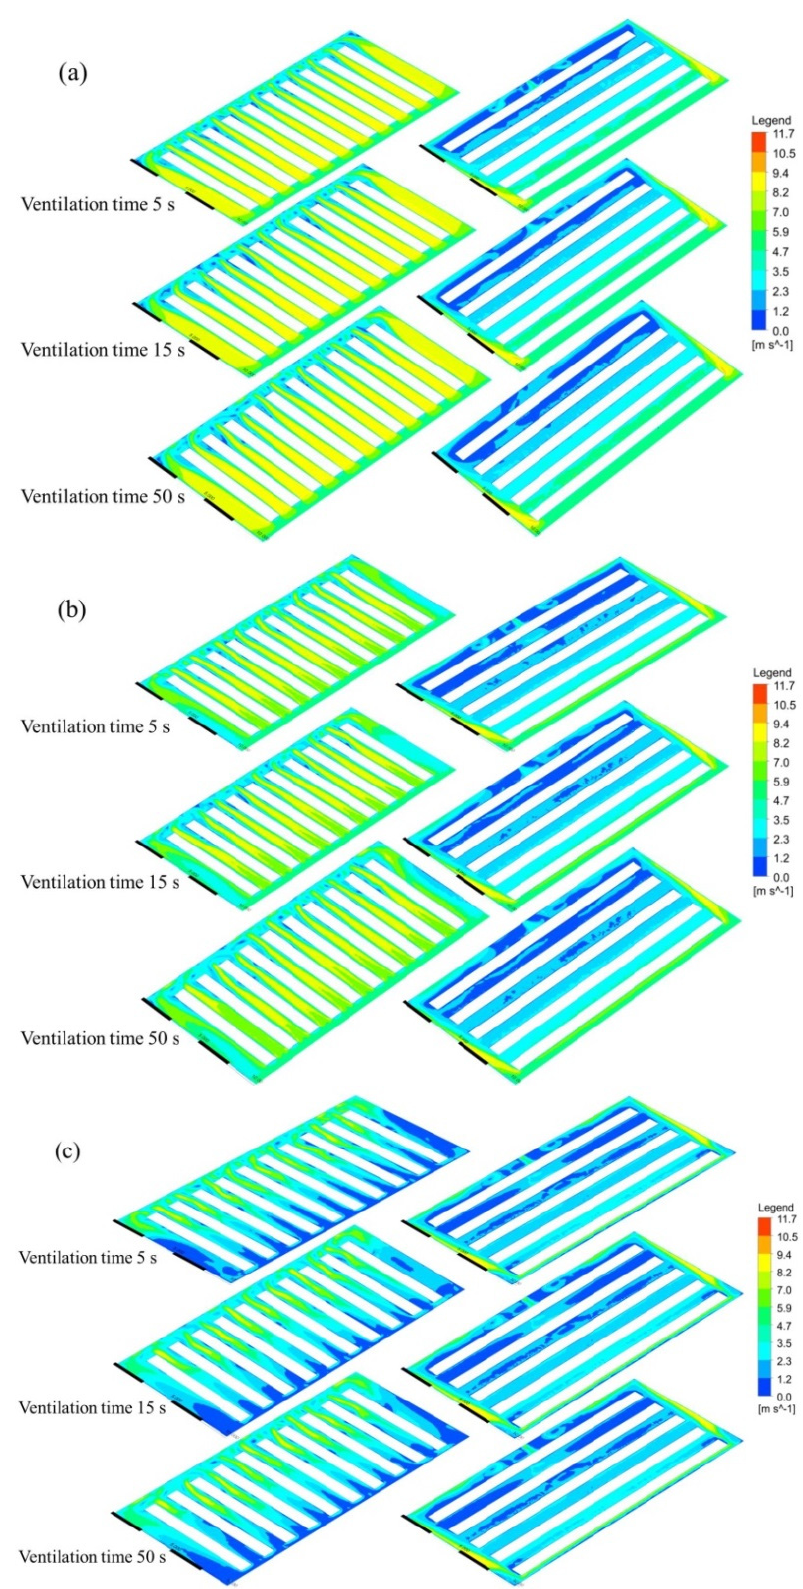
Figure 5. Velocity distributions of typical horizontal cross sections under different arrangements of cultivation racks: ( a ) 0.5 m height; ( b ) 1.0 m height; ( c ) 1.5m height.